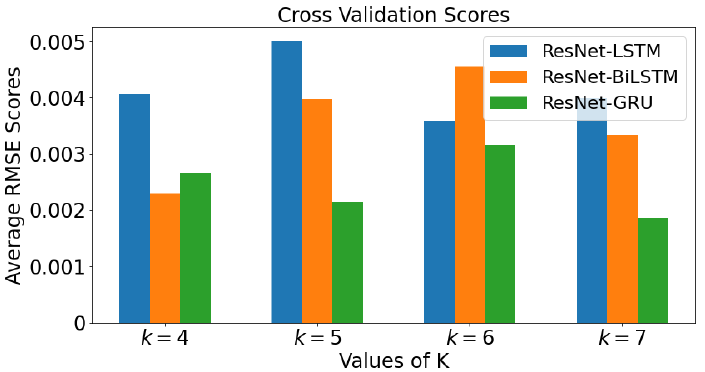
Figure 18. Cross Validation Scores using mean scores for each value of k for ResNet data.